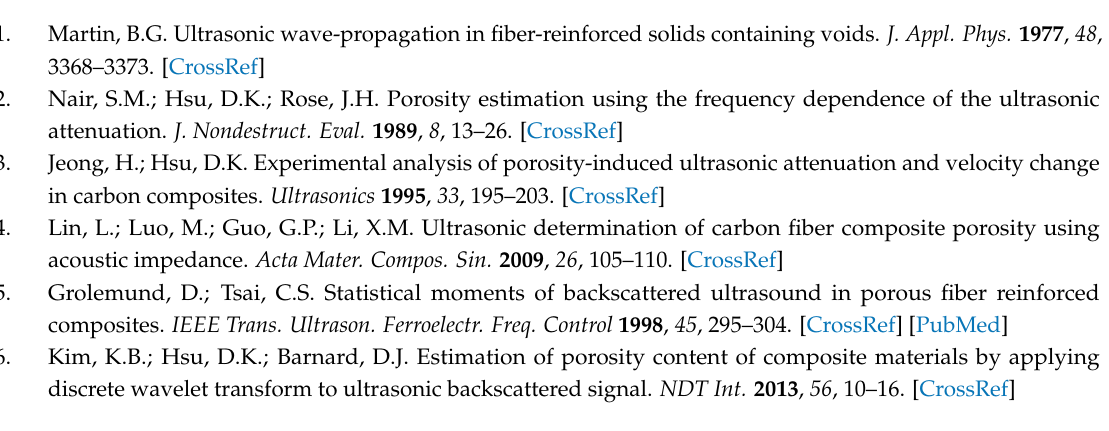
Figure 14. Modes extracted by VMD with parameters K = 3 and α = 16. ( a ) Intrinsic mode functions; ( b ) spectrums of intrinsic mode functions; ( c ) GST spectrums of intrinsic mode functions; and ( d ) projection of GST spectrum of C2.